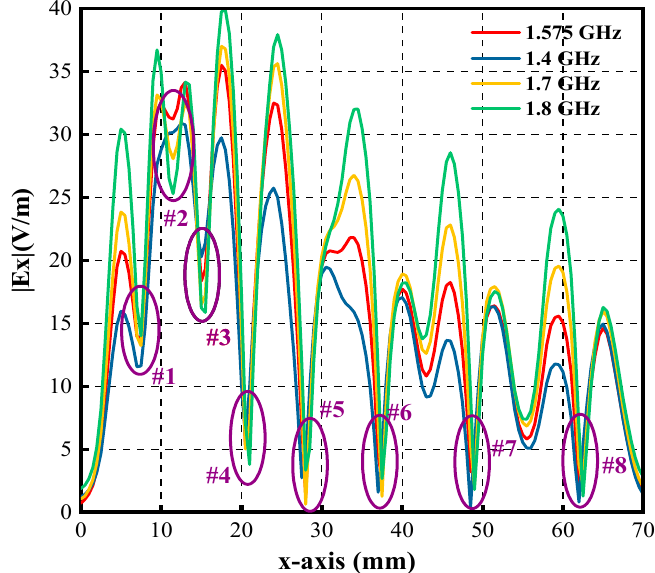
Figure 25. Measured electric field of the meander line along the x-direction.